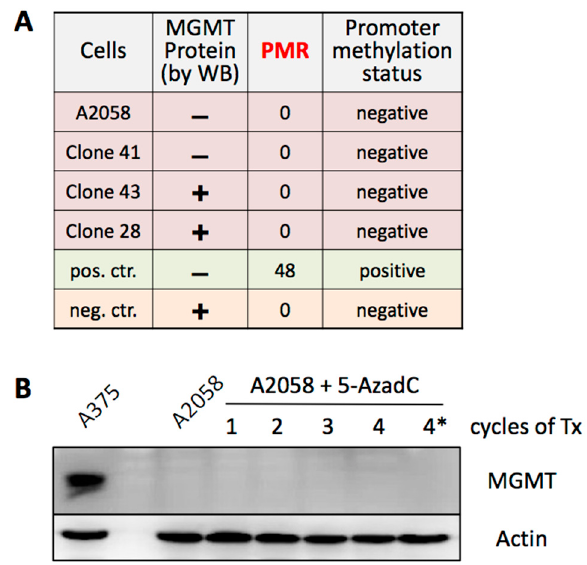
Figure 7. MGMT promoter methylation status. ( A ) DNA was isolated from A2058 cells and several derived clones, and analyzed for methylation status of the MGMT promoter. Reference DNA from RKO and HCT8 colorectal carcinoma cell lines was included as negative (neg. ctr.) and positive controls (pos. ctr.), respectively. PMR: percentage of methylated reference. ( B ) A2058 cells were treated (Tx) with 1, 2, 3, or 4 cycles of 5-AzaC. Thereafter, cell lysates were prepared and analyzed for MGMT protein levels by WB. Actin was used as the loading control. Cell lysate labeled 4* was from cells that were cultured for an additional 4 weeks after 4 cycles of 5-AzaC treatment.